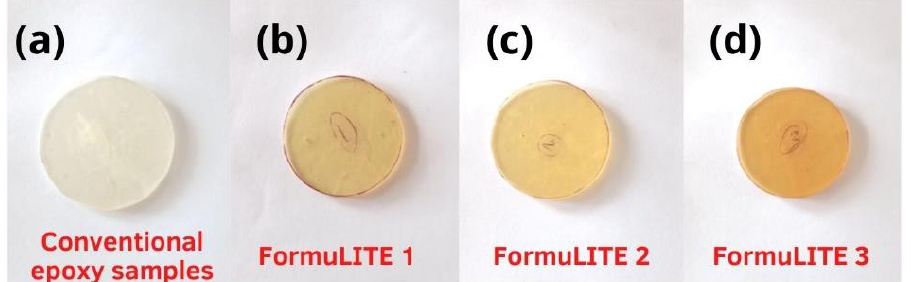
Figure 6. Water absorption test specimen dimension as per ASTM D570-98 standard, ( a ) conventional epoxy, ( b ) FormuLITE 1, ( c ) FormuLITE 2, and ( d ) FormuLITE 3.